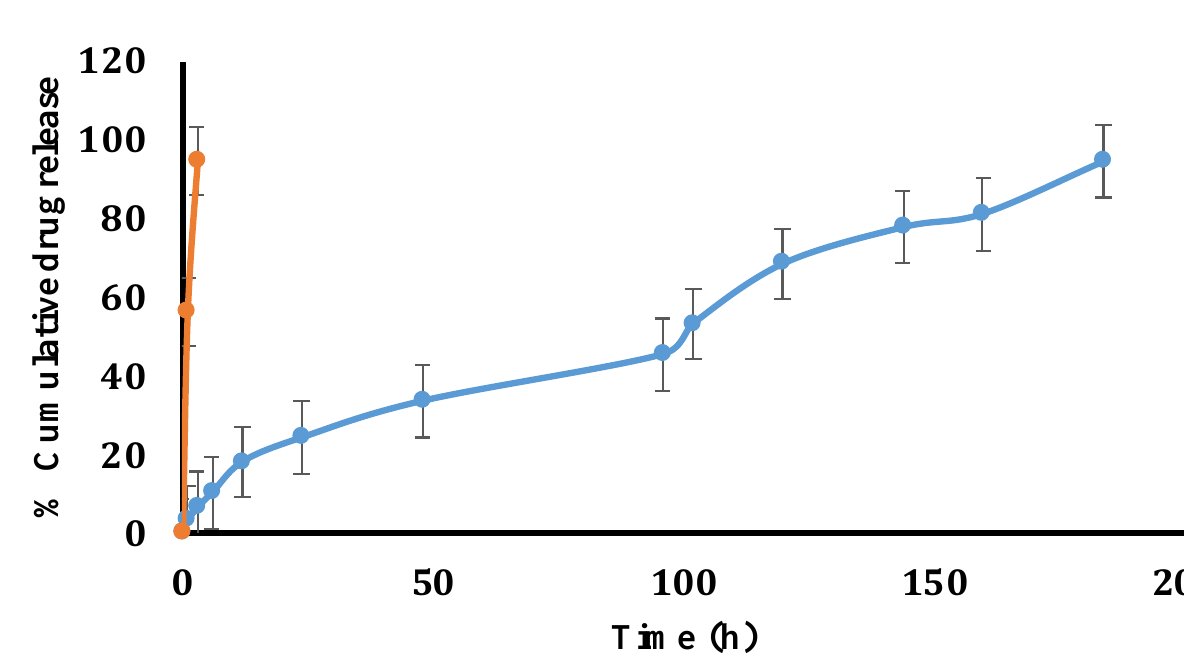
Figure 3. In vitro release profile of CPG-NP-coated sutures (blue lines) and CPH-coated sutures (orange) at different time intervals. (orange) at different time intervals.